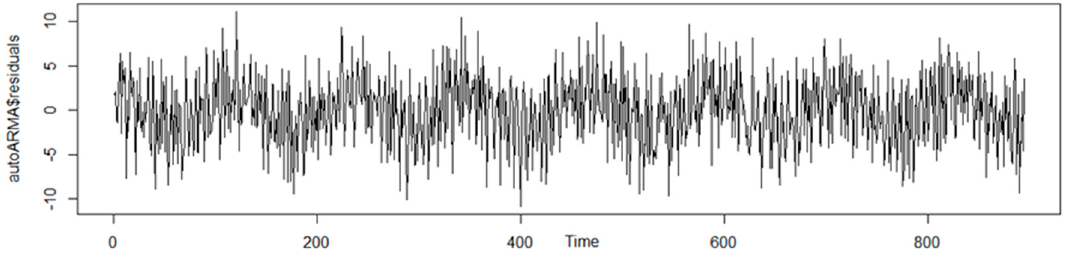
Figure 12. Autoregressive (AR) (4) residual model (own